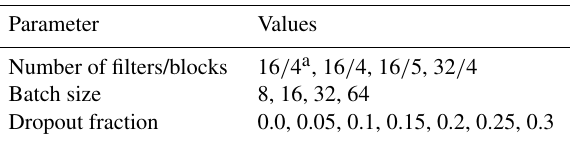
Table 3. Parameters that are used to find the best parameter setup for the standard